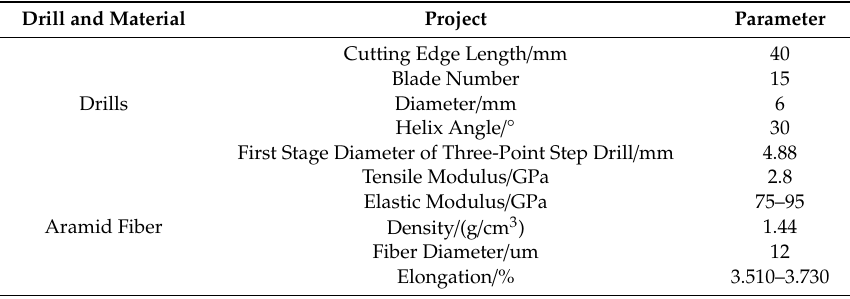
Figure 6. The three kinds of drills for the experiment. Table 1. Parameters of drills and aramid fiber.